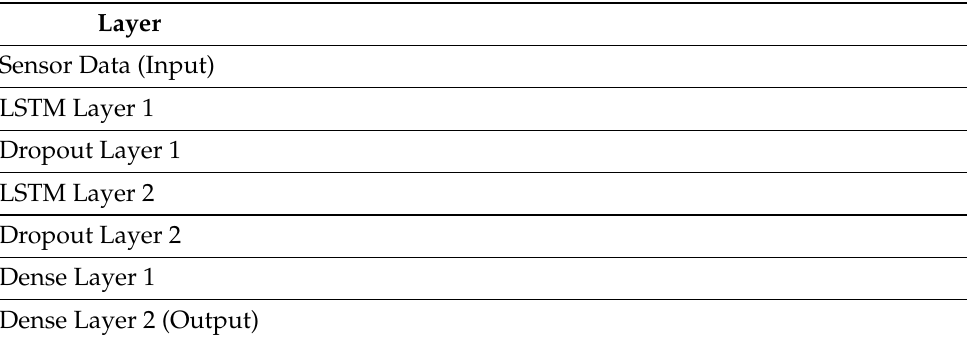
Table 7. Chosen RNN